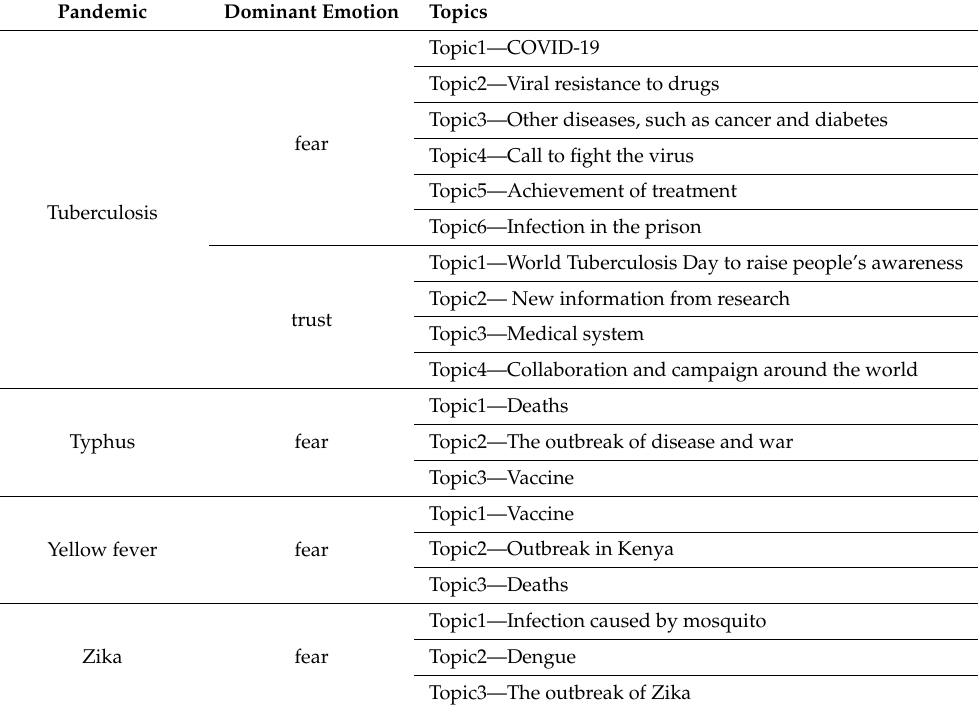
Table 5. Topics for pandemic and emotion pair: tuberculosis, typhus, yellow fever, and Zika are listed with the fear emotion; tuberculosis also shows topics for the trust